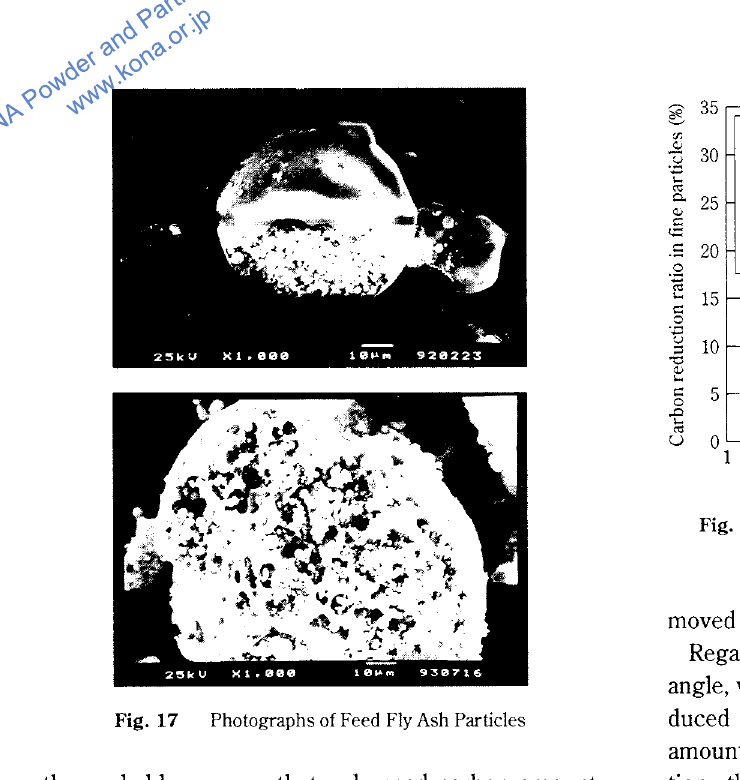
Fig. 17 Photographs of Feed Fly Ash Particles